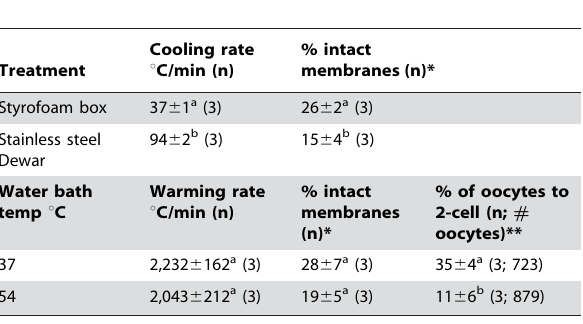
Table 2. Suitable cooling and warming rate